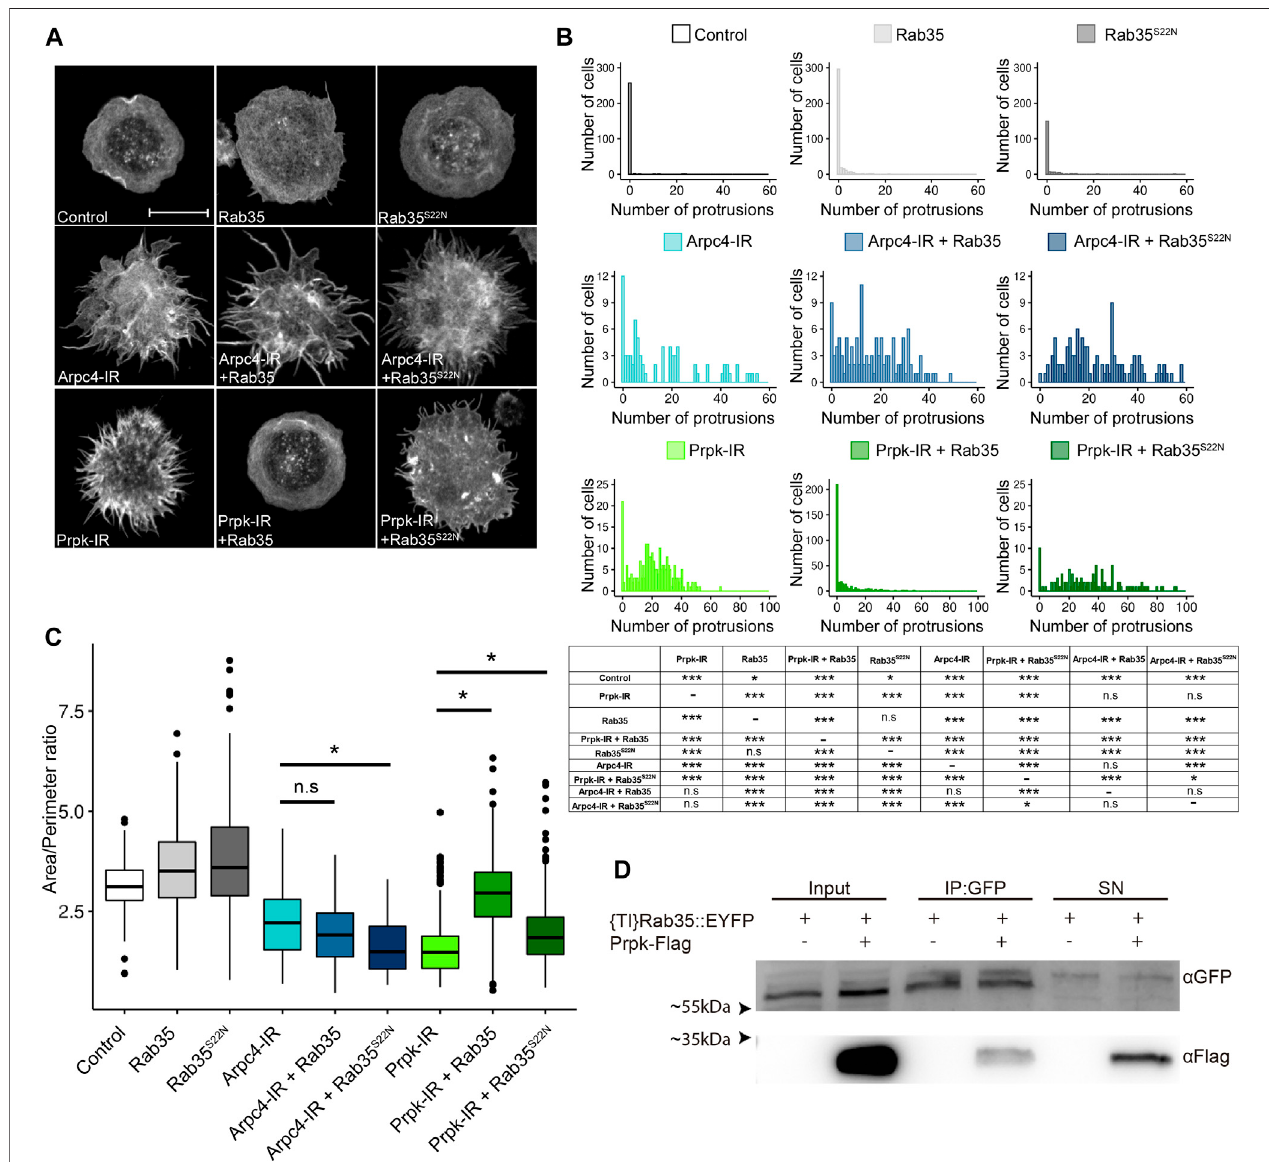
FIGURE4| PrpkfunctionallyinteractswithRab35incellshapemaintenanceandlamellipodiastructuration. (A) F-ActinstainwithPhalloidininhemocytes.Lossand gain of functions were induced in hemocytes using the Cg-Gal4 driver for each condition: mCD8:GFP ( Control), Rab35 tagged to YFP (Rab35), YFP tagged version of a dominant negative form of Rab35 (Rab35 S22N ), Arpc4-IR, Arpc4-IR + Rab35, Arpc4-IR + Rab35 S22N , Prpk-IR, Prpk-IR + Rab35 and Prpk-IR + Rab35 S22N . Scale bar: 10 μ m. (B) Quanti fi cation of the number of protrusions for each condition. Data are presented as frequency of cells with protrusions and the statistical differences are summarized in the inserted table. The Kolmogorov-Smirnov test was used for data analysis, with a Bonferroni correction: * p < 0.05, ** p < 0.01, *** p < 0.001; n ≥ 4 (number of coverslips analyzed, quanti fi ed more than 150 cells in each case). (C) Cell morphology quanti fi cation expressed like Area/perimeter ratio for each condition. Kruskal – WallistestwasusedfordataanalysisfollowedwithpairwisecomparisonsusingWilcoxonranksumtest.Alltheconditionsevaluatedshowsigni fi cantdifferences with the control. Statistical differences are indicated by bars. * p < 0.001; n ≥ 4 (number of coverslips analyzed, more than 150 cells were quanti fi ed in each case) (D) Co- immunoprecipitation between Prpk-Flag and {TI}Rab35:EYFP. Inputs, Immunoprecipitation and Supernatants (SN) conditions are detailed in each case. The image corresponds to a representative blot, n =